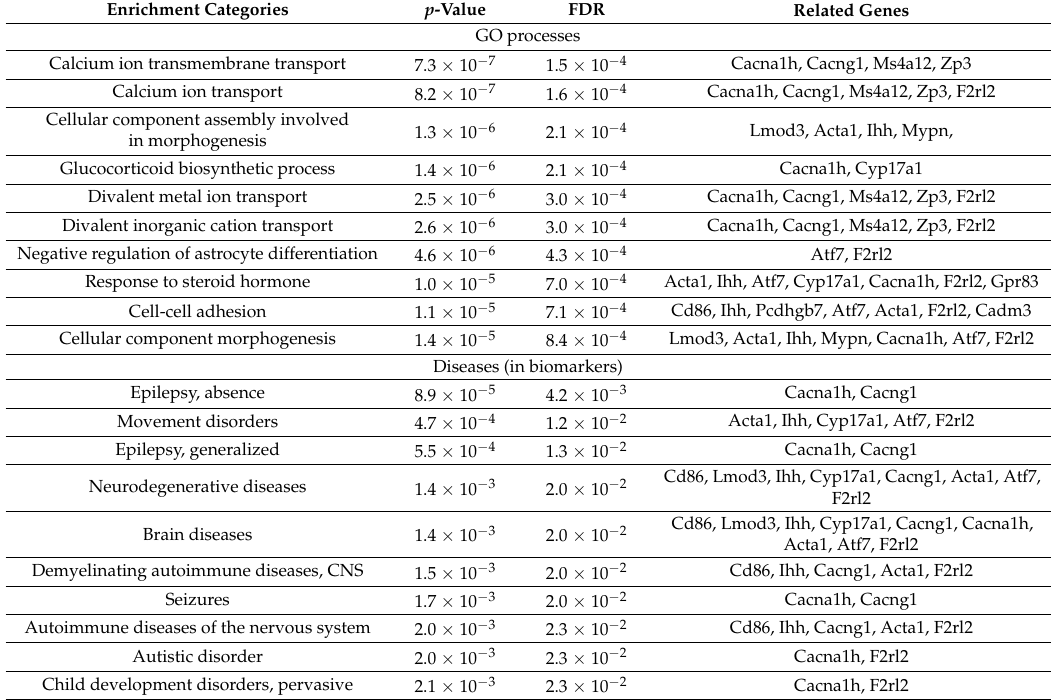
Table 5. MetaCore enrichment analysis of DE genes in CvN.